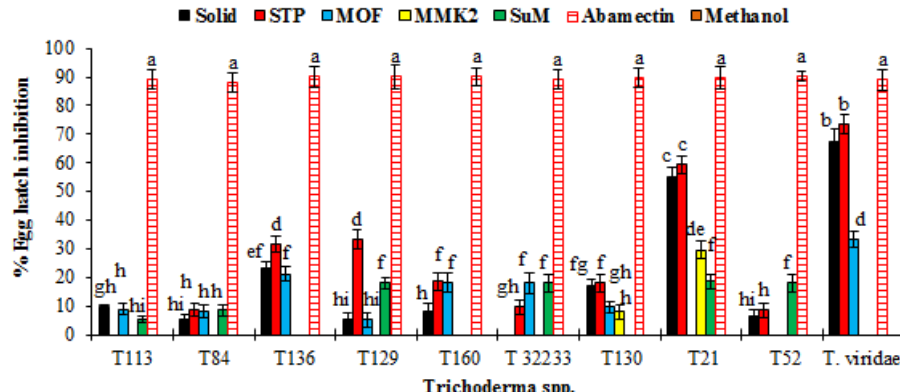
Figure 4. Effect of SMs of Trichoderma spp. obtained on different growth media on egg hatching of M. incognita . Values are the mean of three replicates. The bar represents the mean with standard deviation. Missing columns for some treatments indicated their 0.0% egg hatch inhibition (or no activity). Treatments having similar lettering on the bar chart show no significant ( p ≥ 0.05) difference according to Fisher’s protected LSD test.